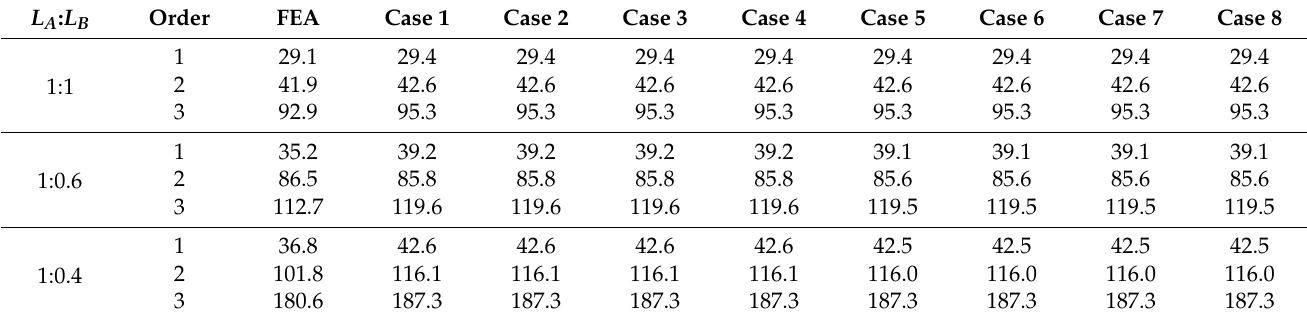
Table 8. The result of numerical calculation for fundamental mode of two components type.